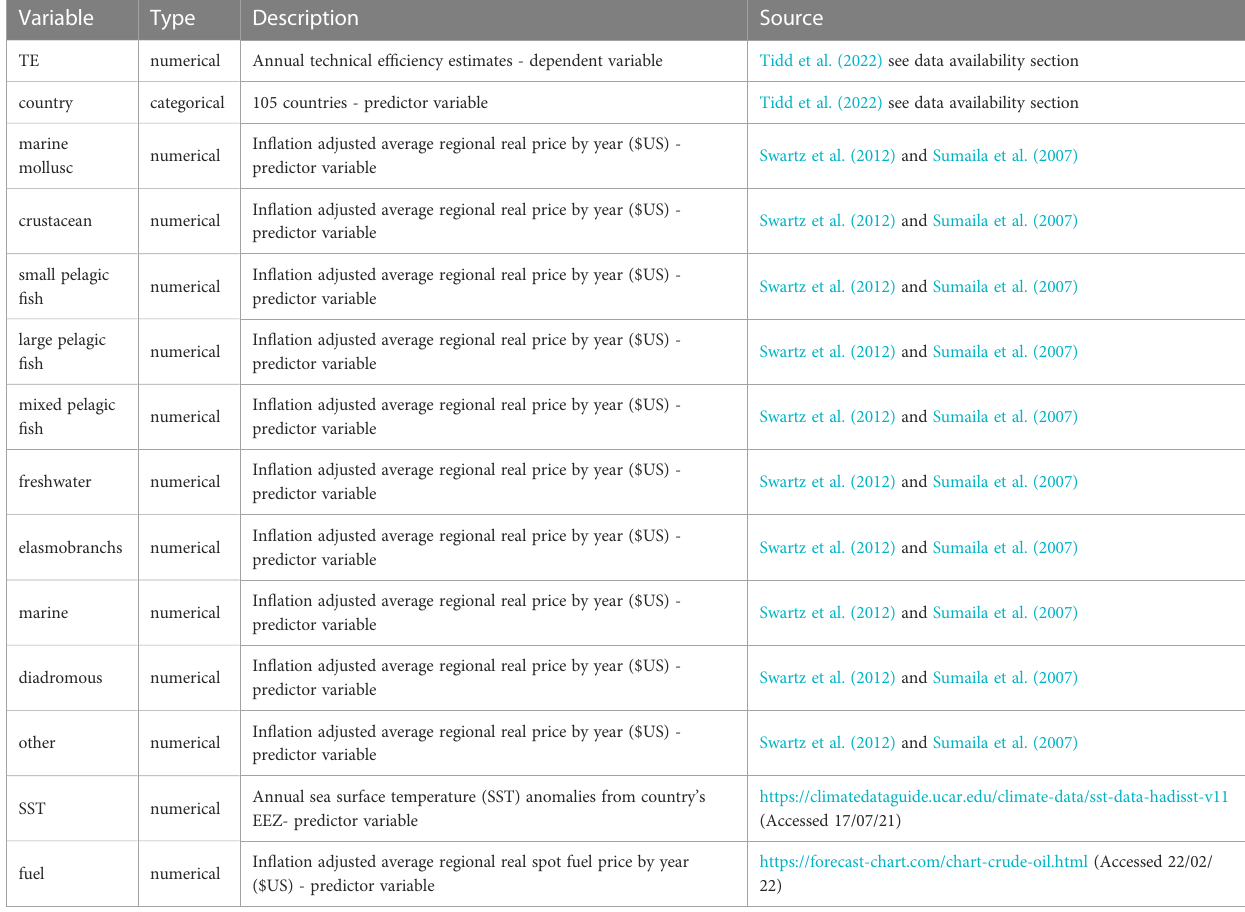
TABLE 1 Variable description and